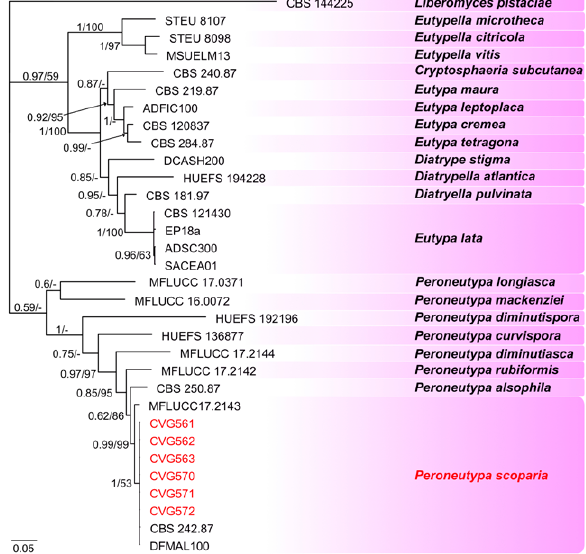
Figure 5. Consensus phylogram of 3,242 trees resulting from a Bayesian analysis of the combined ITS and tef1 sequences of Cadophora strains. Bayesian posterior probability values and boot- strap support values are indicated at the nodes. The tree was rooted to Neofusicoccum parvum (CBS 110301).